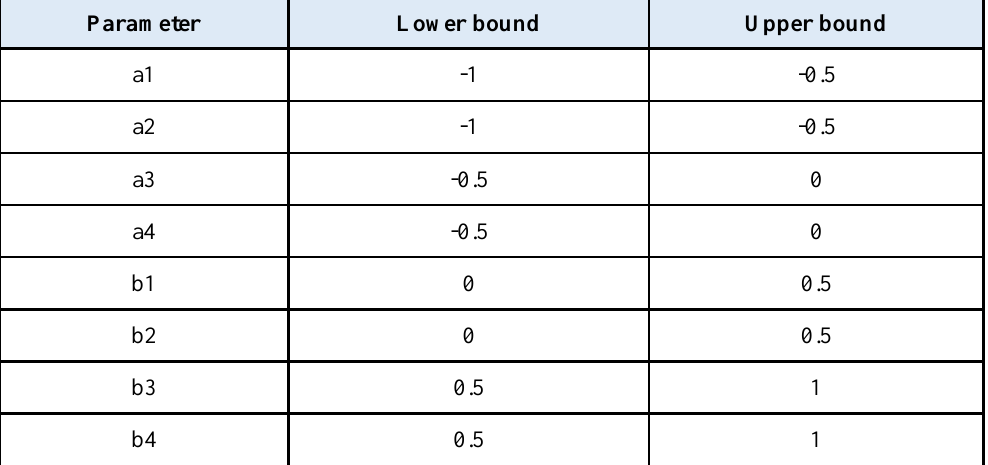
Table 3. Selected Intervals for the Parameters of the Membership